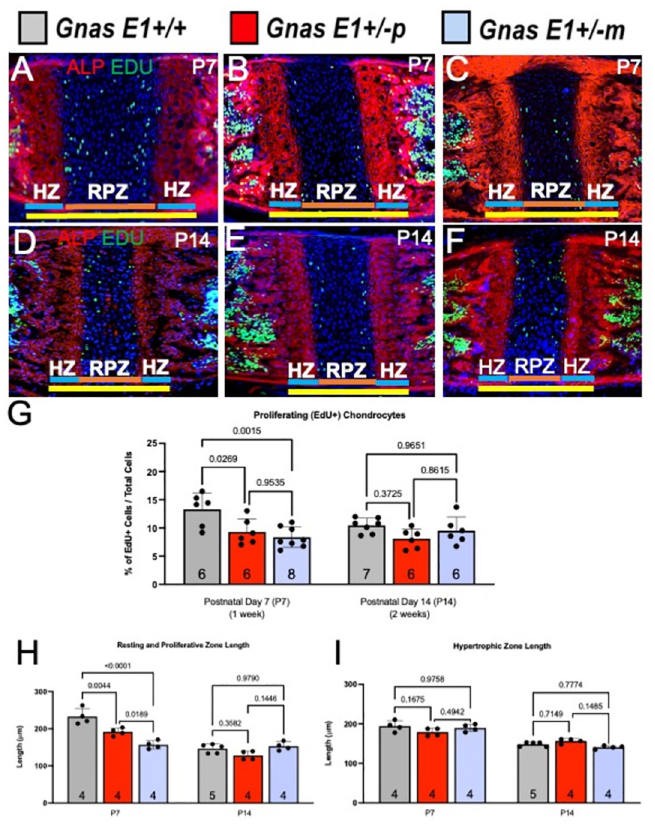
Fig 6. Accelerated reduction in spheno-occipital synchondrosis length within E1+/- mice is associated with a reduction in the number of proliferating chondrocytes. (A-F) Representative images of the SOS (yellow line) in (A-C) 1-week-old mice and (D-F) 2-week-old mice. In Fig 6 (A, D) are WT, (B, E) are Gnas E1+/-p, and (C, F) are Gnas E1+/-m mice stained for Alkaline phosphatase (red), EdU (green), and DAPI (blue). (G) Quantification of the percentage of EdU+ chondrocytes to the total number of chondrocytes within the resting and proliferative zone at 1 week of age demonstrates that both Gnas E1+/-p and Gnas E1+/-m mice display a significant reduction in proliferating chondrocytes compared to WT. No significant differences were observed at 2 weeks of age. (H) Quantification of the resting and proliferative zone lengths (defined as ALP negative zone of synchondrosis) (blue line) were significantly reduced in both Gnas E1+/-p and Gnas E1+/-m mice when compared to WT at 1 week of age. No significant differences were observed at 2 weeks of age. (I) Quantification of the hypertrophic zone length (defined as ALP+ zone of synchondrosis) (orange lines) demonstrated no significant differences between WT and Gnas E1+/- mice at 1 or 2 weeks of age. Sample size per genotype per experiment is listed on each graph. All statistical tests were completed using a two-way ANOVA with post-hoc Tukey test for multiple comparisons, and p -values are displayed for each